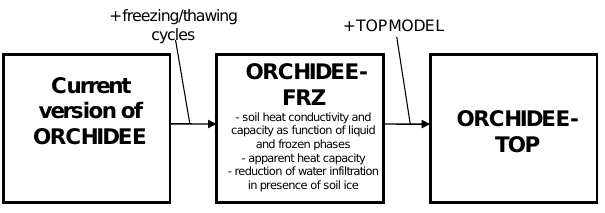
Fig. 1. Flow-chart of the different developments brought to the OR- CHIDEE